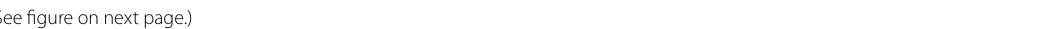
Fig. 7 Biosafety and reproductive safety analysis of IgG78‑DM1 in C57BL/6 mice. A , B Food intake and body weight of different groups after IgG78‑DM1 or hIgG‑DM1 treatment. C – E Kidney function, liver index (liver weight/body weight), and liver function showing the biosafety of IgG78‑DM1 in CCl 4 ‑induced mice. F H&E staining of different organs in CCl 4 ‑induced mice after IgG78‑DM1 or hIgG‑DM1 treatment (n Scale bar, 50 μm. G H&E staining of embryos in early, middle, and late stages of pregnancy in normal C57BL/6 mice after IgG78‑DM1 or hIgG‑DM1 treatment. H – K Duration of pregnancy, change in body weight during pregnancy, number of offspring, and weight of the pups in each group (n 5 in G – K ). Representative images are shown. DM1 Mertansine, H&E hematoxylin =